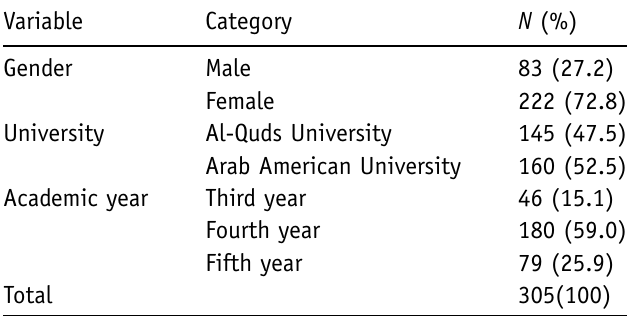
Table I. Demographic characteristics of the participants.